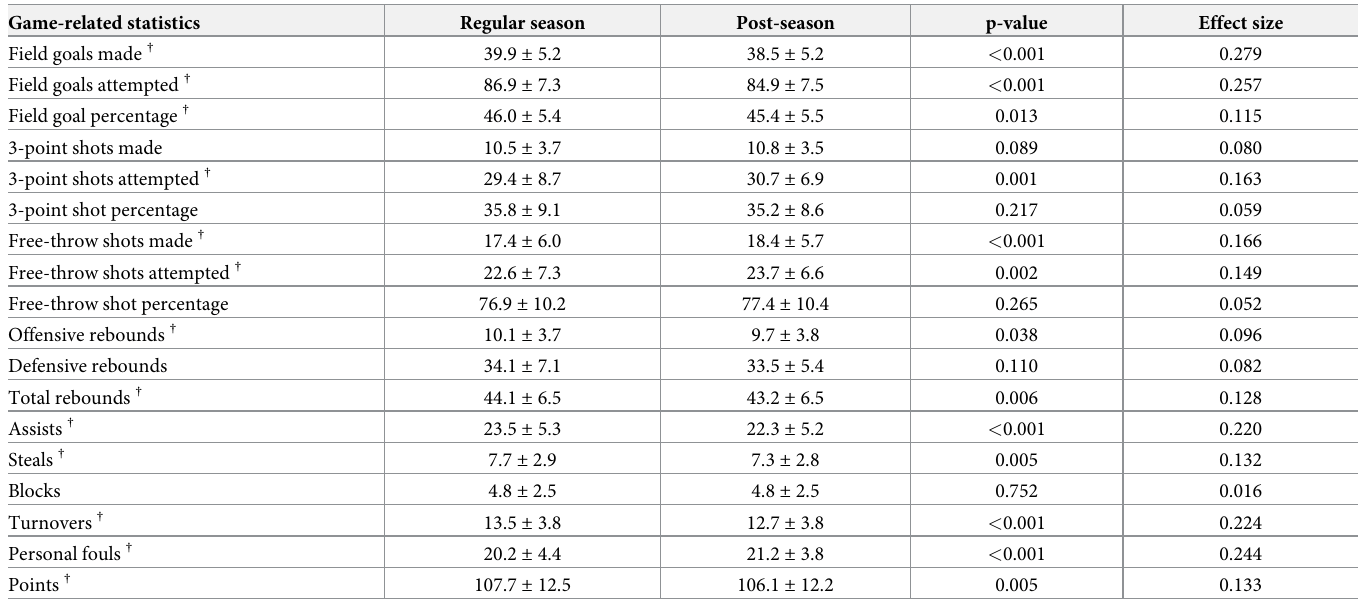
Table 1. Descriptive data ( � x � ± SD) for game-related statistical parameters between the regular and post-season competitive periods.